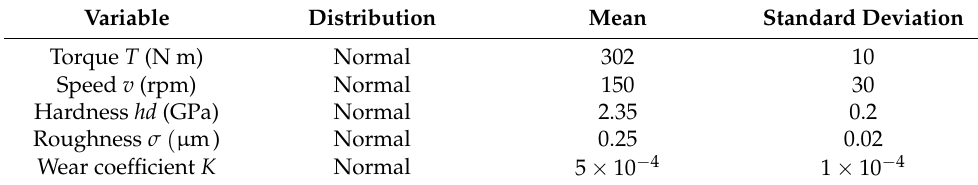
Table 2. Distribution information of variables.